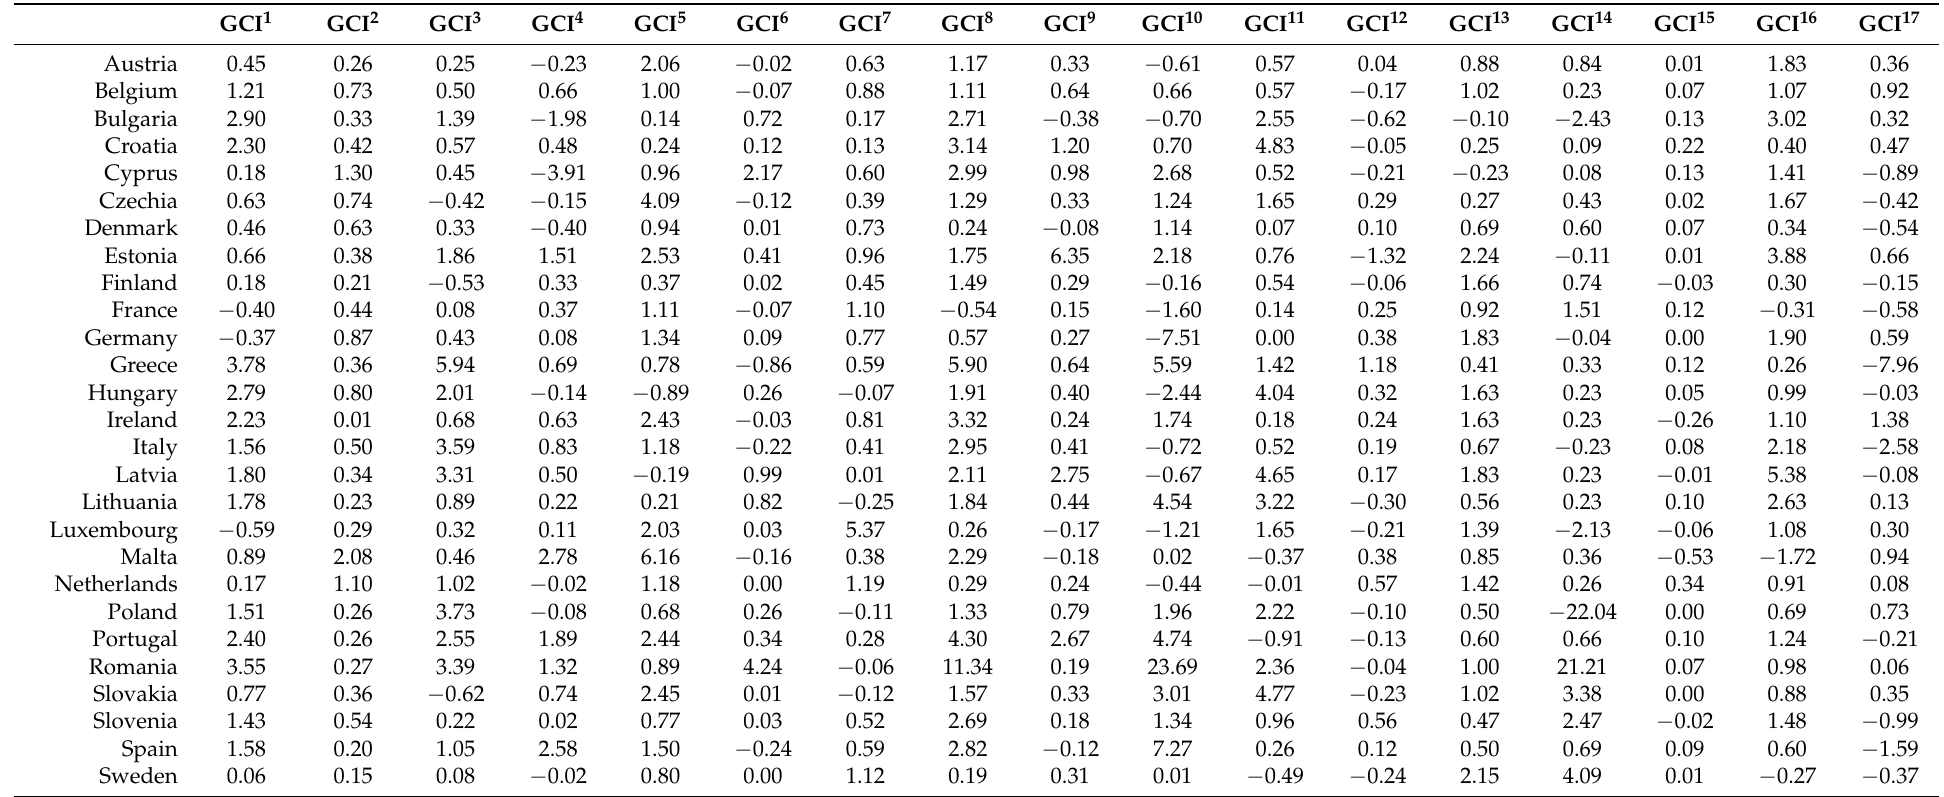
Table 5. SDG composite indicators’ annual variation rate, 2020–2015, goals 1 to